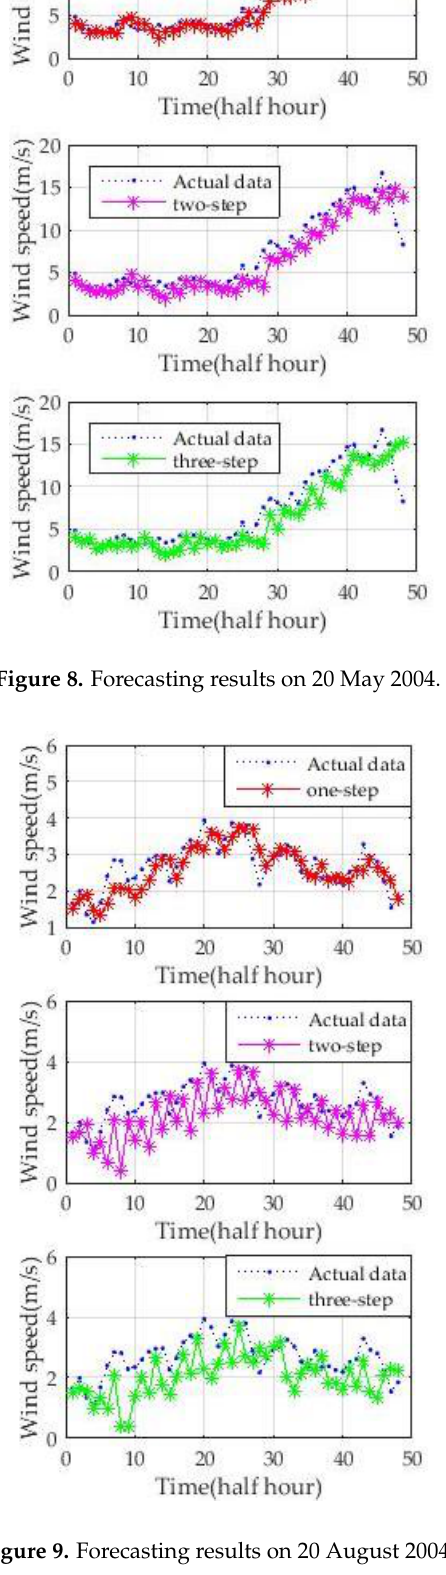
Figure 9. Forecasting results on 20 August 2004.